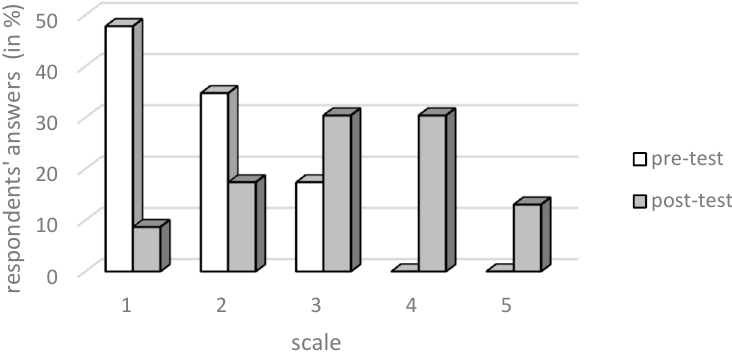
Figure 7. Respondents’ answers to question no. 12 (in %) in pre-test and post-test.